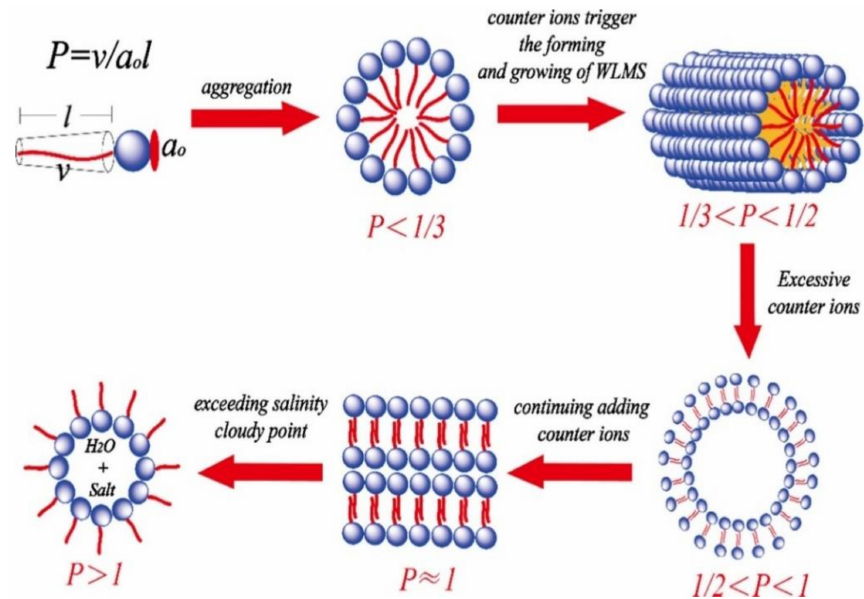
Figure 1. The effect of additional counter ions on the behavior of the VES phase [42]. The degree of contra-ion binding is determined by the hydrophobicity and micelliza- tion of the counterion. Electrostatic screening for the repulsion between the surfactant head groups occurs by oppositely charged counterion ions due to organic or inorganic salts mixed with various surfactants. Halide ions from organic salts such as Cl − or Br − are considered to be adsorption to the micelle surface based on weak to relatively weak interactions with the surfactant cations. Whereas inorganic salts such as sodium salicylate (NaSal) are tightly bound to the surface head groups, micelle form transition improves when salt concentration decreases [72,73]. The micelle disrupts under certain shear